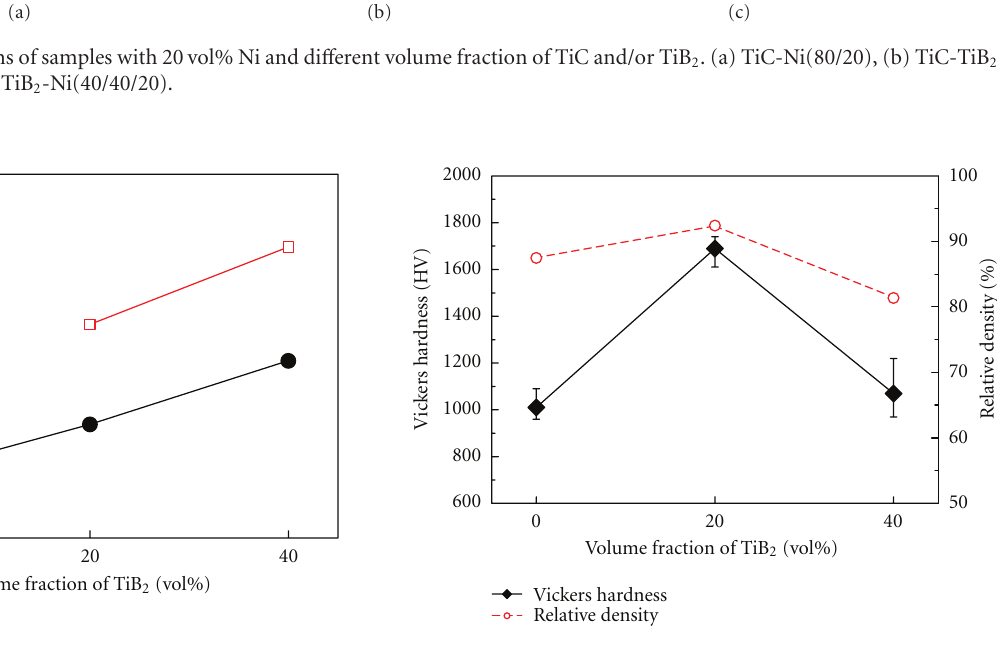
Figure 6: E ff ect of TiB 2 volume fraction on average particle size of samples with 20 vol% Ni.